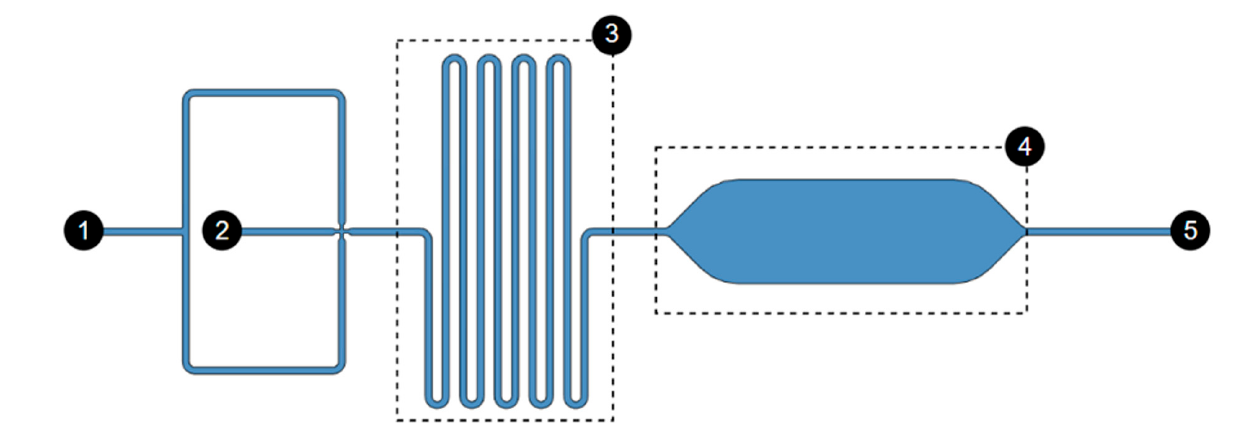
Figure 1. The microfluidic device schematic diagram with a Droplet generator (1) and (2)—Channels for supplying liquid substances (3)—Reaction zone; (4)—Droplet collector ; (5)—emulsion collection